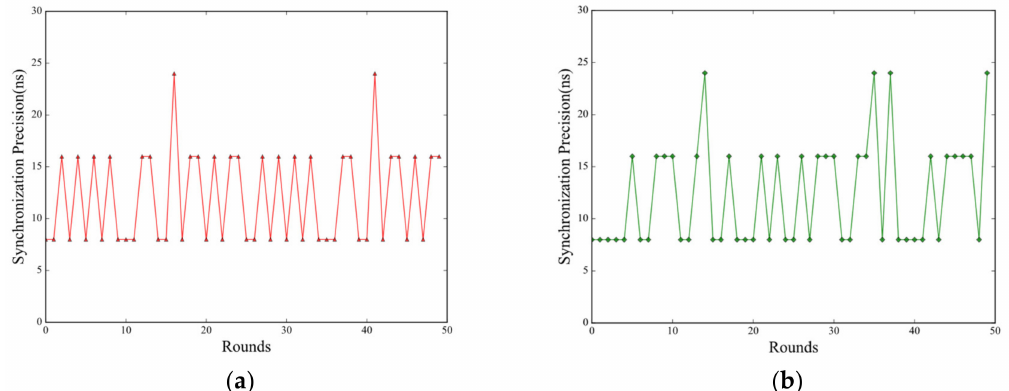
Figure13. Thesynchronizationprecisionofnetworkcomparisonbetweentraditionalfinitestatemachine